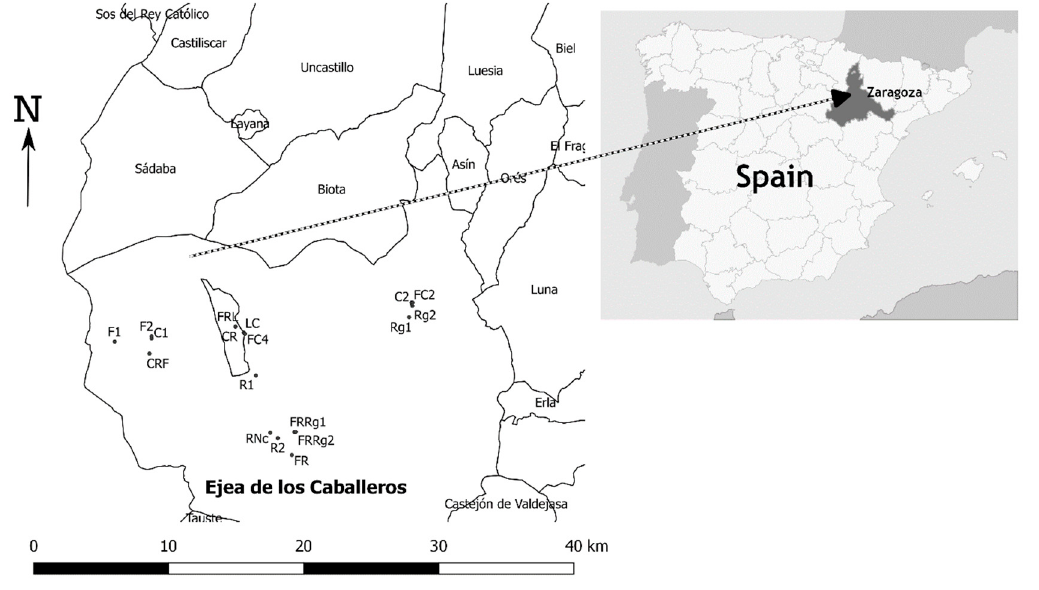
Figure 1. Map showing the position of the different surveyed fields.